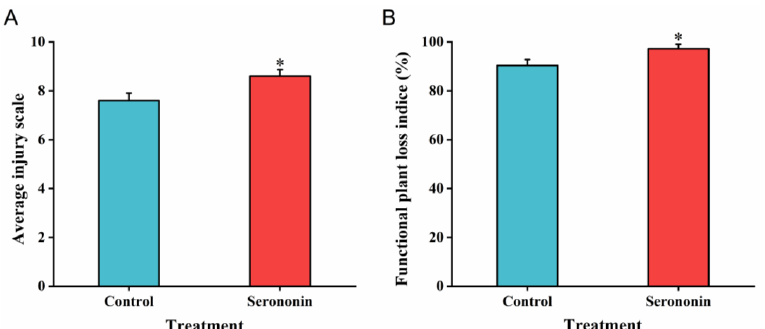
Figure 5. Effects of exogenous serotonin on rice tolerance to BPH infestation. Average injury scale ( A ) and functional plant loss indices ( B ) were examined in rice plants post BPH infestation with or without (control) pre-treatment of serotonin application. Data are means + SE. Asterisks indicate significant difference between treatments (*, p < 0.05; Student’s t -test).